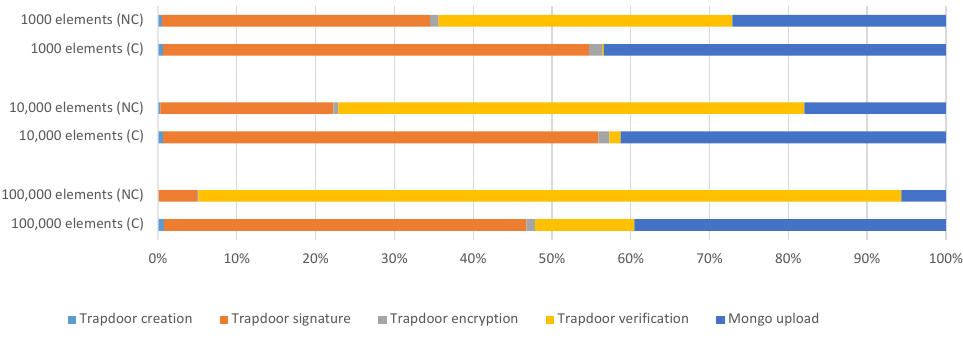
Figure 5. Shared index update duration per stages—with no cache (NC) and with cache (C), in